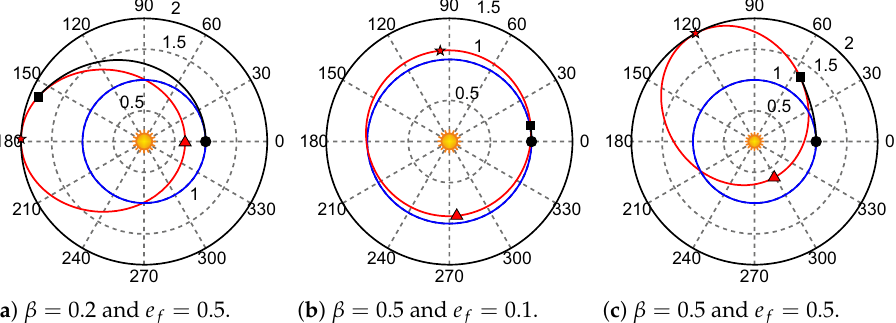
( a ) β = 0.2 and e f = 0.5. ( b ) β = 0.5 and e f = 0.1. ( c ) β = 0.5 and e f = 0.5. Figure 7. Optimal transfer trajectory for some set of design parameters. A more involved transfer trajectory, with a coasting arc, results when β is sufficiently small. For example, Figures 8 and 9 show the numerical simulations for e f = 0.3